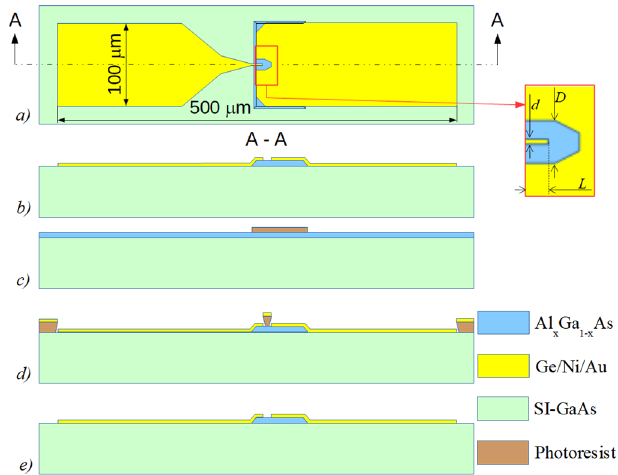
Figure 1. Schematic top ( a ) and cross-sectional ( b ) views of the planar microwave diode. Succes- sive fabrication steps of the diode are shown in parts ( c – e ).